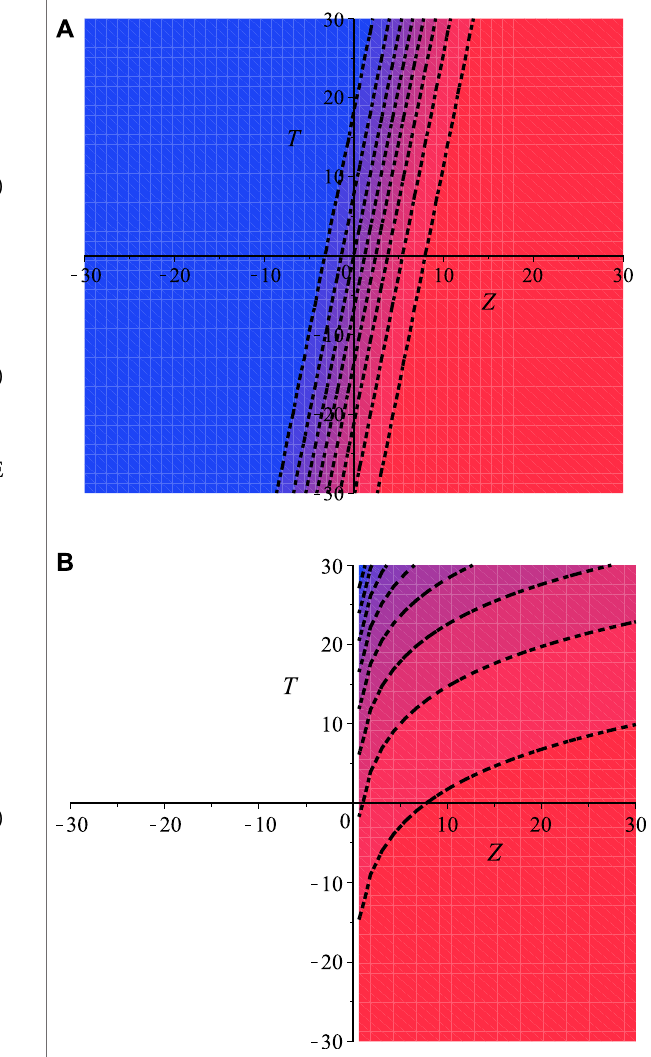
FIGURE1| ContourplotofelectrostaticNIASWEswithrespecttospace and time for (A) β (cid:2) 1 and (B) β (cid:2) 0.1. The remaining parameters are considered as d (cid:2) 1, r (cid:2) e , ρ (cid:2) 0.96, α e (cid:2) 0.5, N p 0 / N e 0 (cid:2) 0.5, T ep (cid:2) 1 and V i 0 / c (cid:2)